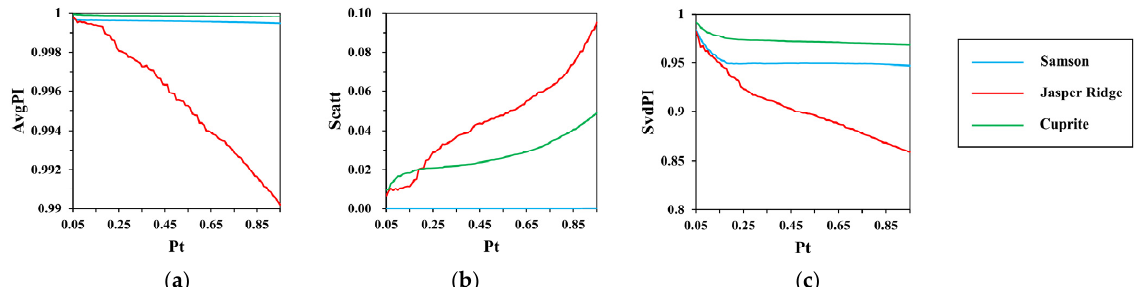
Figure 8. The results of ( a ) Scatt; ( b ) AvgPI; ( c ) SvdPI with the change of Pt.